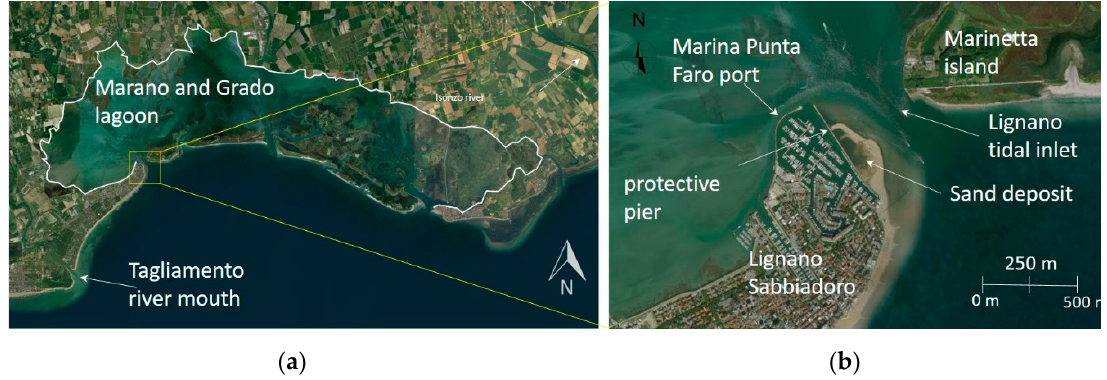
Figure 2. Lignano tidal inlet: ( a ) within the Marano and Grado lagoon context and ( b ) its detail picture.